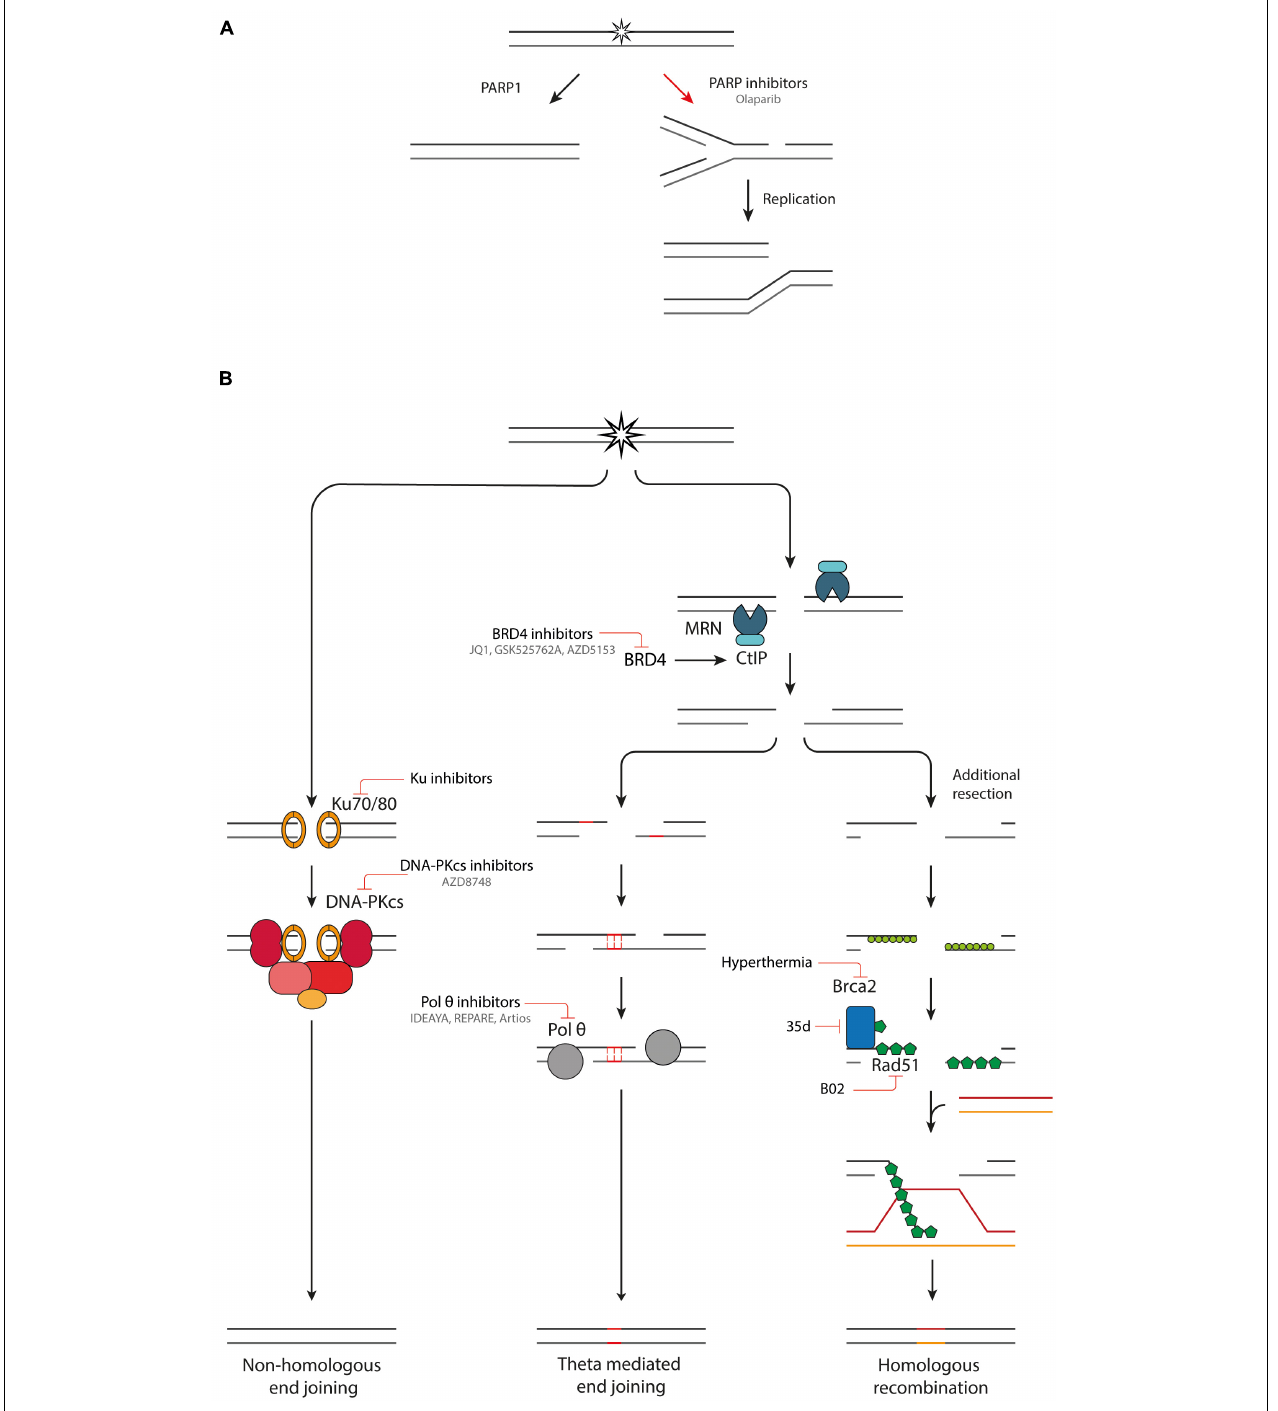
FIGURE 3 | Combination therapies targeting DDR pathways. (A) Inhibition of PARP1 leads to the conversion of SSBs into DSBs upon DNA replication. (B) An overview of NHEJ, TMEJ and HR and inhibitors targeting various components of these pathways.